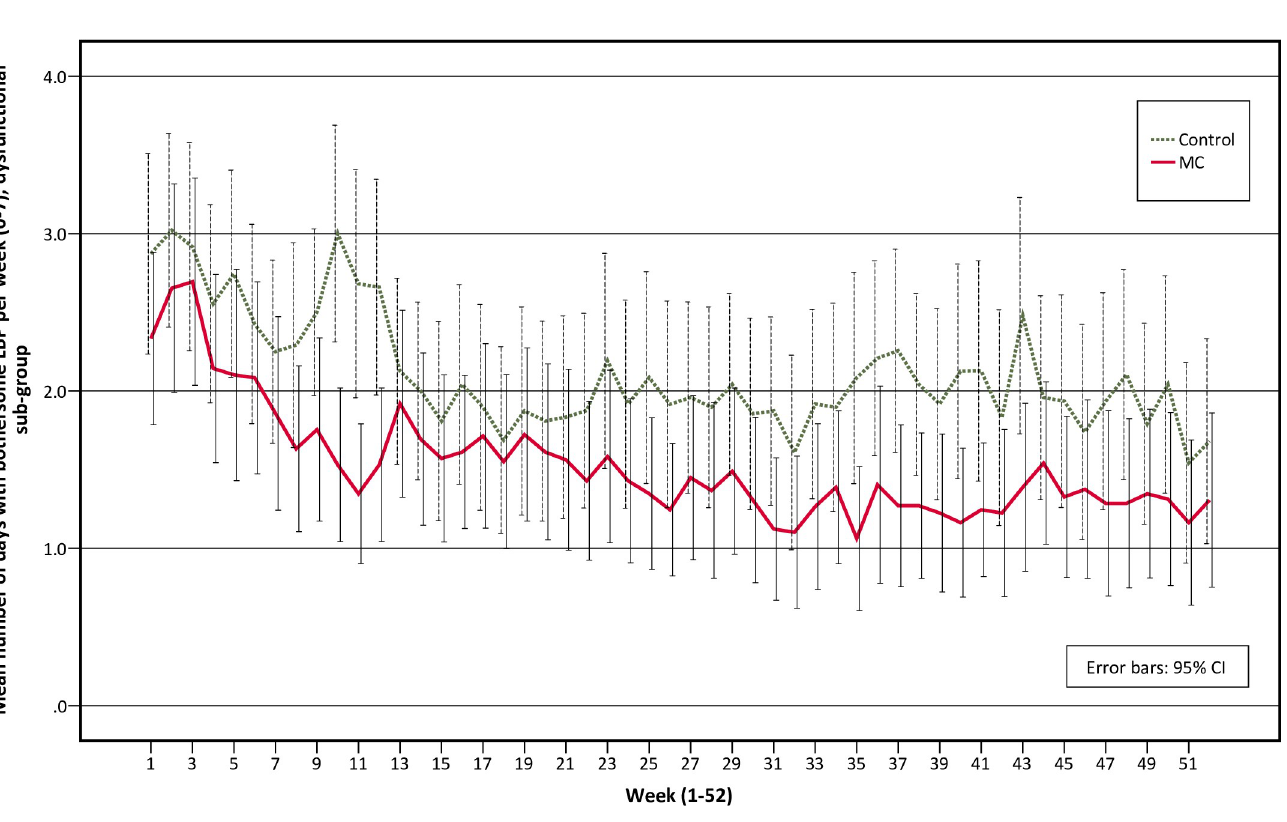
Fig 5. Pain trajectories for treatment groups in the dysfunctional